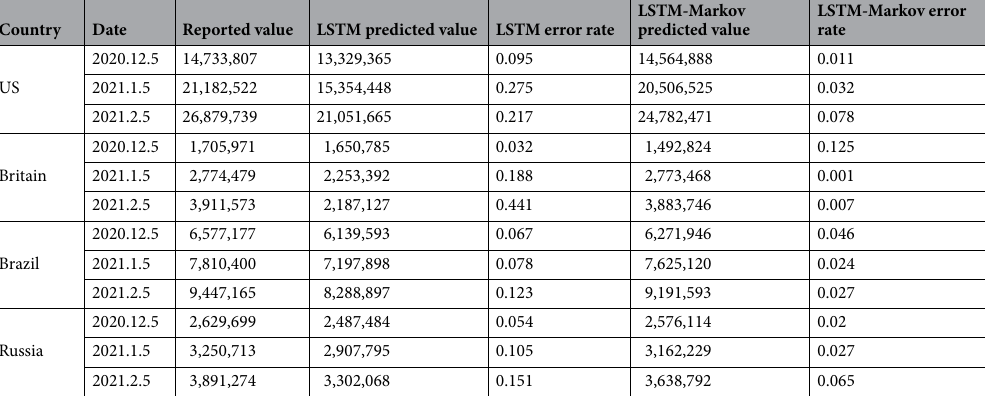
Table 4. Comparison of cumulative confirmed cases reported and predicted on a daily basis.